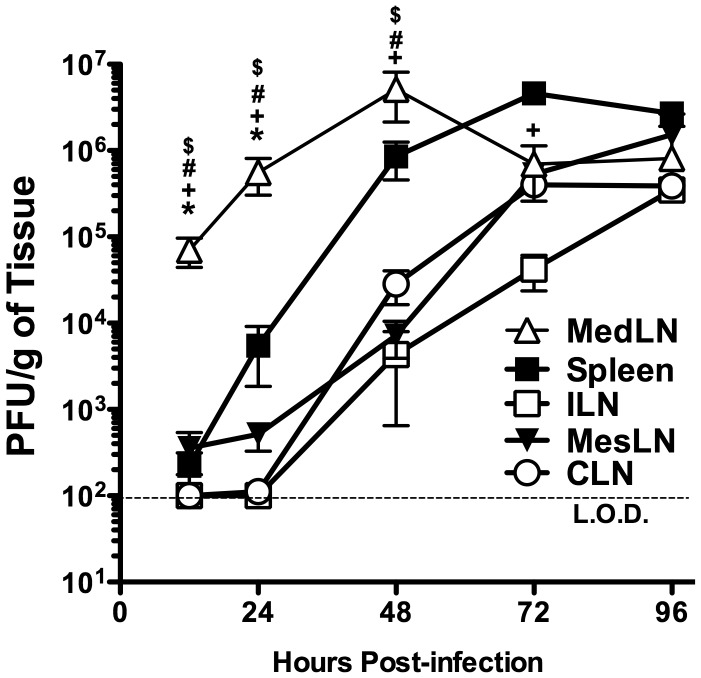
Viral titers in secondary lymphoid tissues early following LCMV infection.C57BL/6 mice were infected with LCMV i.p.. At the indicated times p.i. the spleens, ILNs, MesLNs, CLNs and MedLNs were harvested and assayed for viral titers by plaque assay (A). Data represent pooled data from 3–4 experiments with 3–4 mice per group, except for the ILN and CLN at 0.5 days p.i. where the data represent six mice from two individual experiments. * significantly greater (p<0.05) than spleen +, significantly increased (p<0.05) as compared to ILN. # significantly increased (p<0.05) as compared to MesLN. $, significantly increased as compared to CLN. All statistical analysis was done by ANOVA with a Tukey post-test.